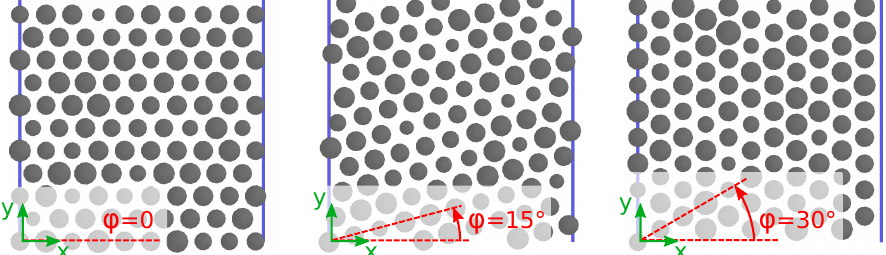
Figure 3. Hexagonal cluster networks in different orientations ϕ